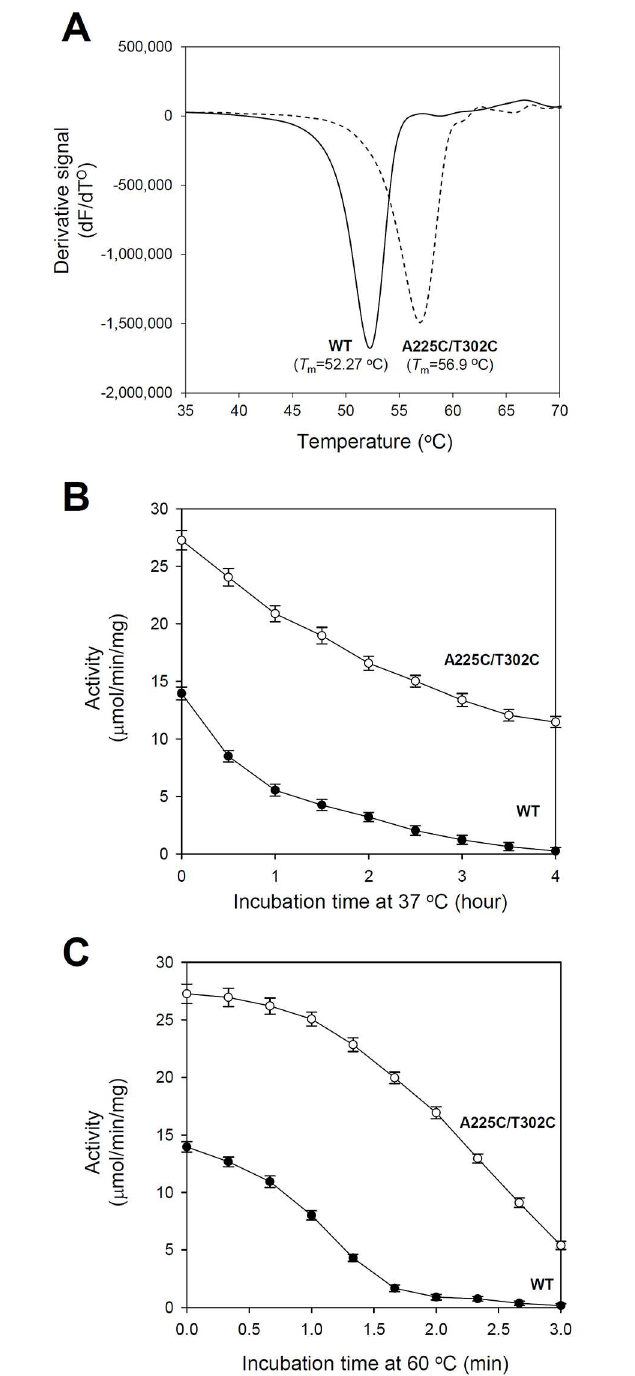
Fig 4. Comparison of resistance to temperature between Sr LDC WT and Sr LDC A225C/T302C . ( A ) Thermal stability measurement of Sr LDC WT and Sr LDC A225C/T302C . The T m values of Sr LDC WT and the Sr LDC A225C/T302C mutant are displayed. ( B ) ( C ) Comparison of thermal stability between Sr LDC WT and Sr LDC A225C/T302C . The LDC activities of Sr LDC WT and the Sr LDC A225C/T302C mutant are measured using proteins pre-incubated at 37˚C ( B ) and 60˚C ( C